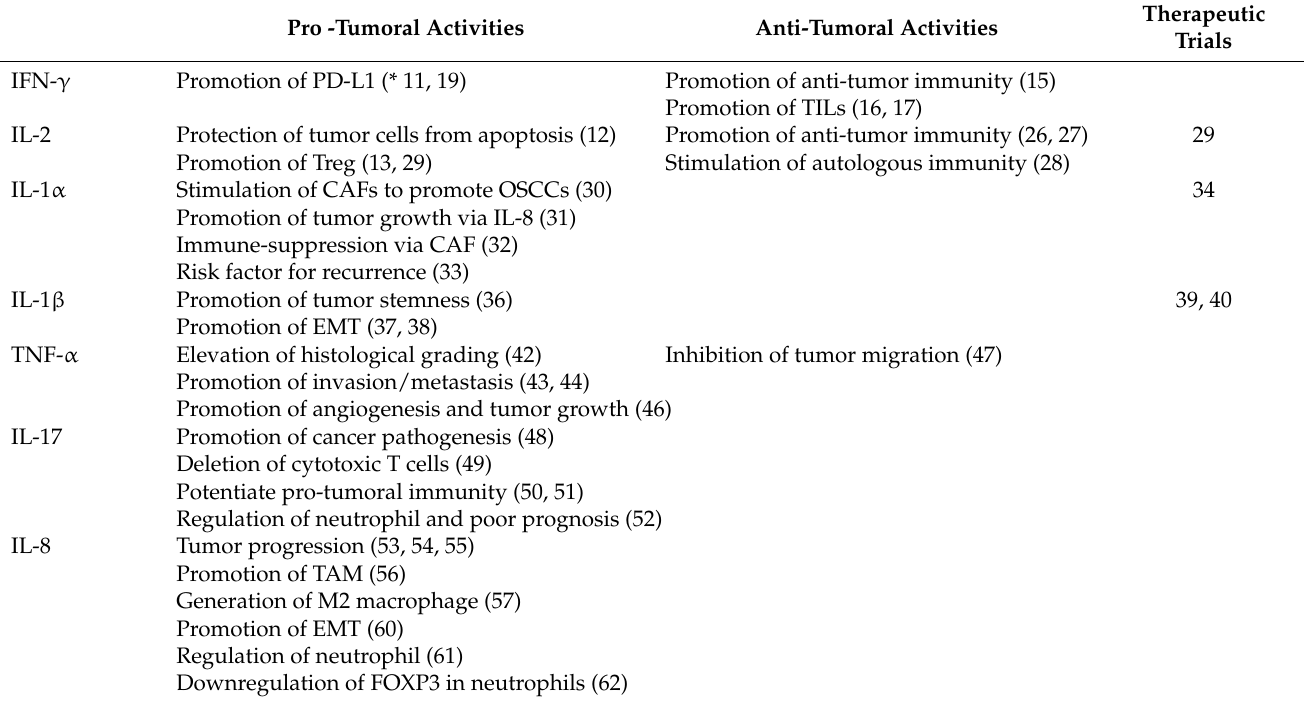
Table 1. Representative pro-inflammatory cytokines relevant to pro-tumoral, anti-tumoral activities and therapeutic trials for HNSCCs.